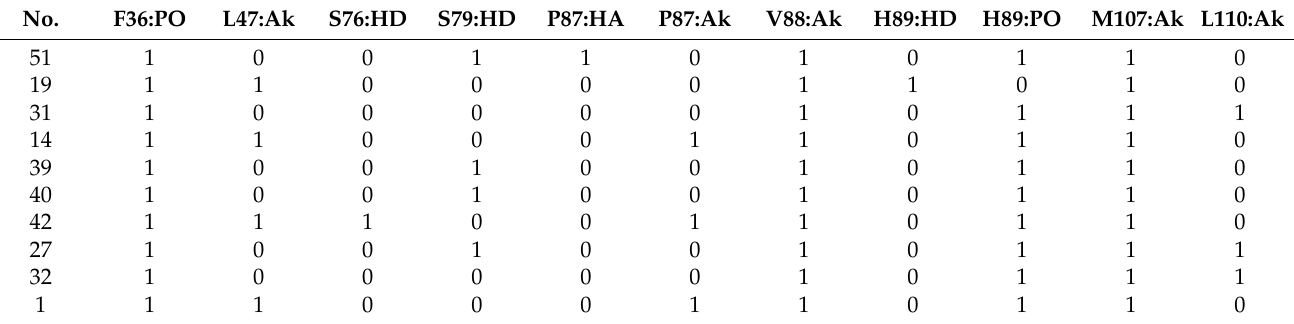
Figure 5. ( A ) LUMO orbit of α -Pinene. ( B ) α -Pinene group compounds docked to DBP. ( C ) Active residues around α -Pinene binding to DBP. Table 1. Fingerprint of the α -pinene group.